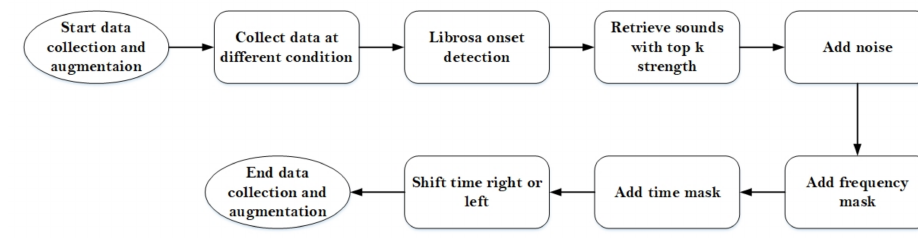
Figure 6. Flowchart of data